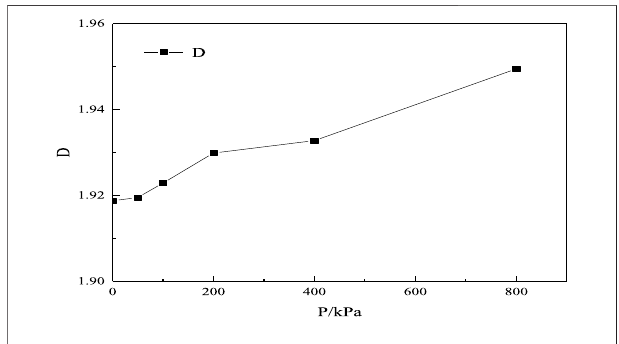
FIGURE 6 | Relation between D and